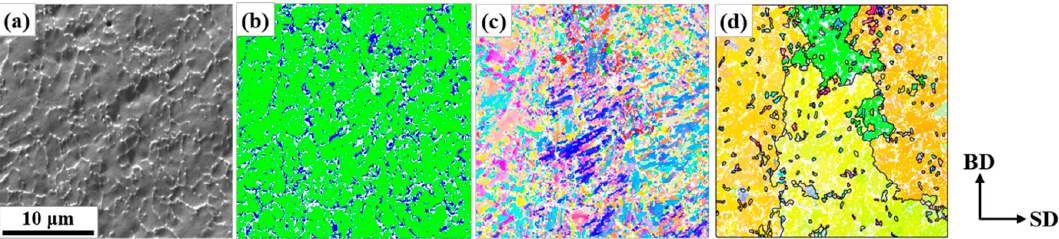
Figure 3. Representative microstructure on the mid-layers of the AM object built at 50 mm/s (C50): ( a ) FSD image, ( b ) phase map, and ( c ) original and ( d ) reconstructed IPF map referred to BD (The phase colors, the IPF color key, and the convention for boundary drawing followed those in Figure 2. The carbides in ( b ) and the twin boundaries in ( d ) were removed for cleanliness).